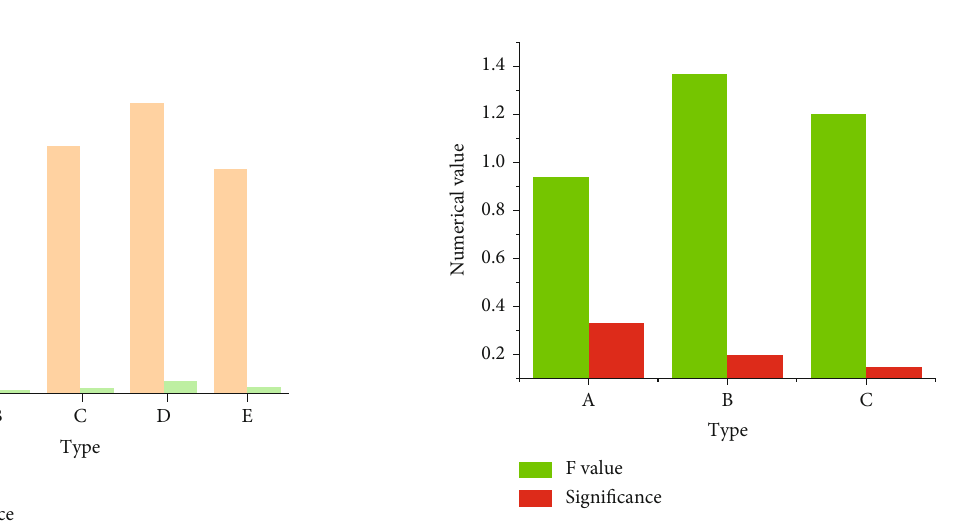
Figure 11 below is the statistics of the regression coe ffi cient of organizational identi fi cation on employees ’ mental health behavior in pro fi t-making enterprises and employee-bene fi ting enterprises.